Question: In a single sentence, describe what this figure presents.
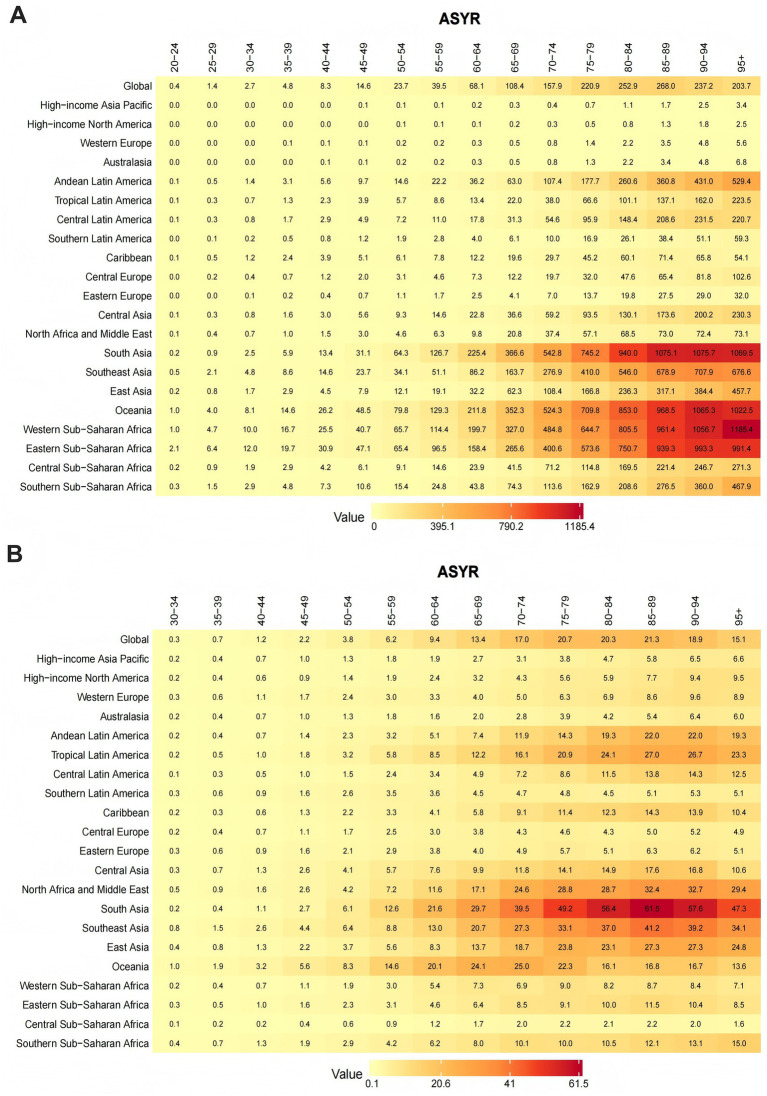
Answer: Heatmap of ASYR for cataract attributable to HAP (A) and smoking (B) , globally and across 21 GBD regions. ASYR, age-standardised YLD rate; HAP, household air pollution.